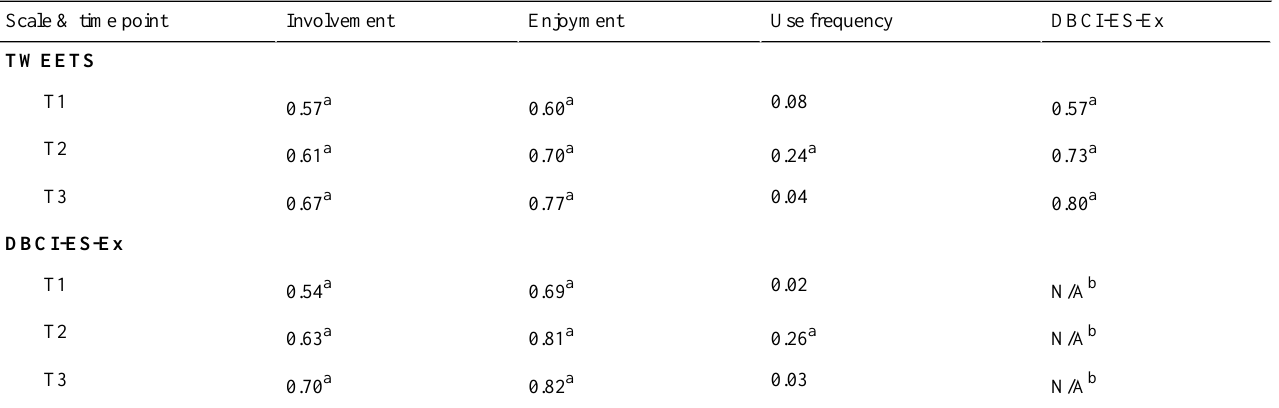
Table 3. Pearson correlations between the TWente Engagement with Ehealth Technologies Scale (TWEETS), the experiential subscale of the Digital Behavior Change Intervention Engagement Scale (DBCI-ES-Ex), involvement, enjoyment, and use frequency.